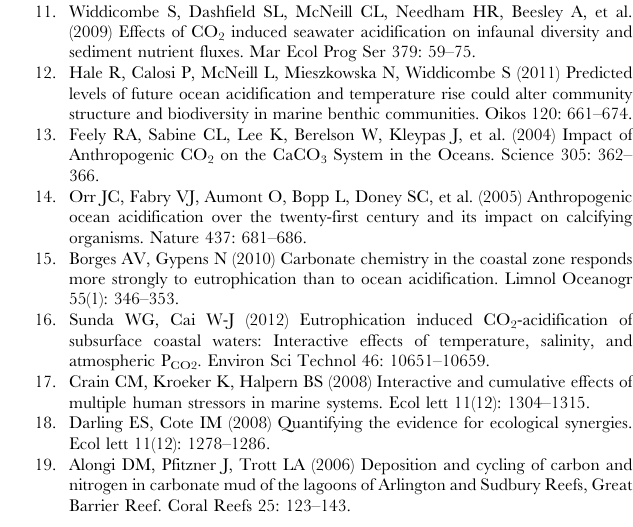
Table S4 Generalized Linear Model summary (regres- sion-based models with Gaussian distribution and identity link function) indicating the significance of dissolved reactive phosphorus (DRP) on dissolved inorganic nitrogen (DIN) among treatments (OM: Or- ganic matter, CC: Calcium carbonate, Mix: OM + CC, Control). Table S5 Generalized Linear Model summary (regres- sion-based models with Gaussian distribution and identity link function) indicating the significance of chlorophyll a content on the total macrofauna abun- dance and the abundance of deposit feeders among treatments (OM: Organic matter, CC: Calcium carbon- ate, Mix: OM + CC, Control). SE: Standard Error. Table S6 Generalized Linear Model summary (regres- sion-based models with Gaussian distribution and identity link function) indicating the significance of NO 3 2 flux during daylight on the abundance of deposit feeders (DF) among treatments (OM: Organic matter, CC: Calcium carbonate, Mix: OM + CC,